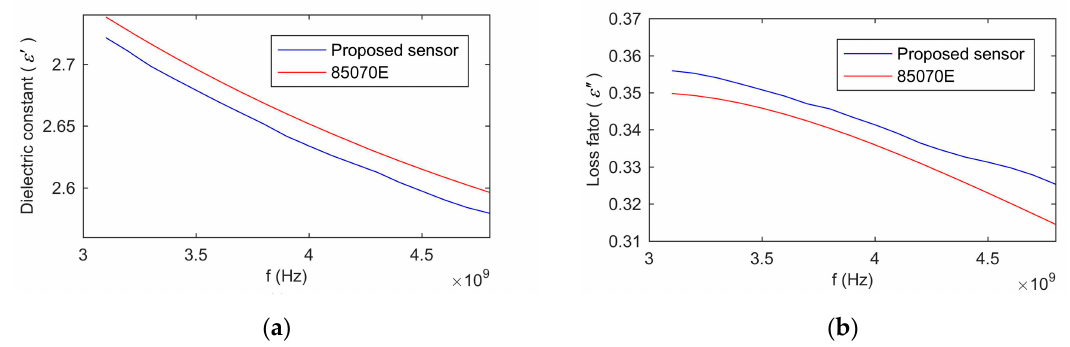
Figure 13. The complex permittivity of decanol measured by the proposed sensor versus probe 85070E at 20 °C : ( a ), dielectric constant; ( b ), loss factor.